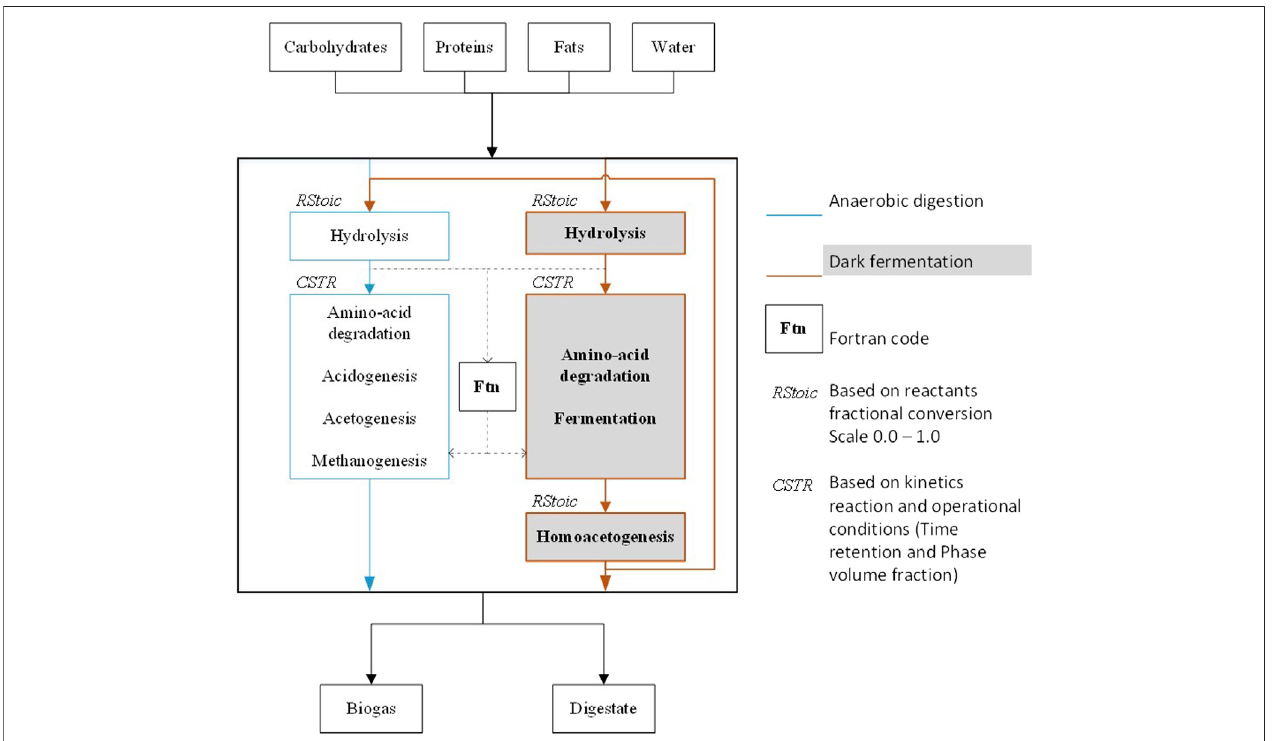
FIGURE 1 | Block diagram of simulated processes in Aspen